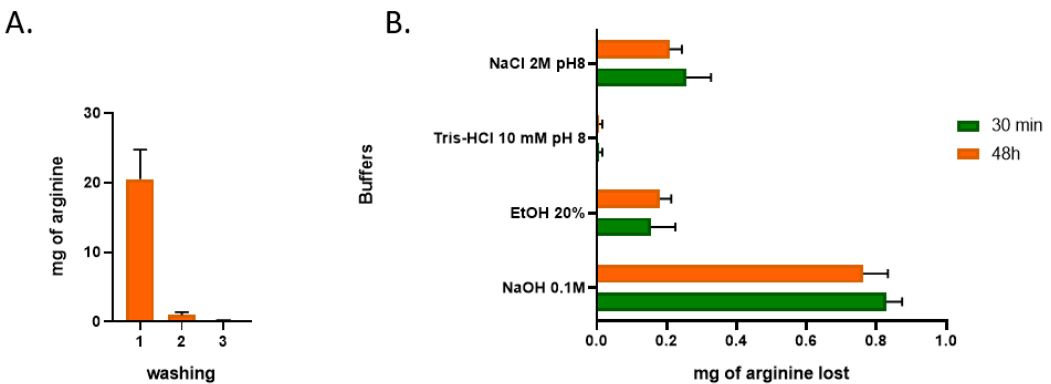
Figure 5. Loss of arginine after the 3D-printed chromatographic structures came into contact with different buffers. ( A ) Arginine lost after several washing steps with water; ( B ) arginine lost in PCL structures washed twice with water, after coming into contact with different buffers for 30 min or 48 h ( n =